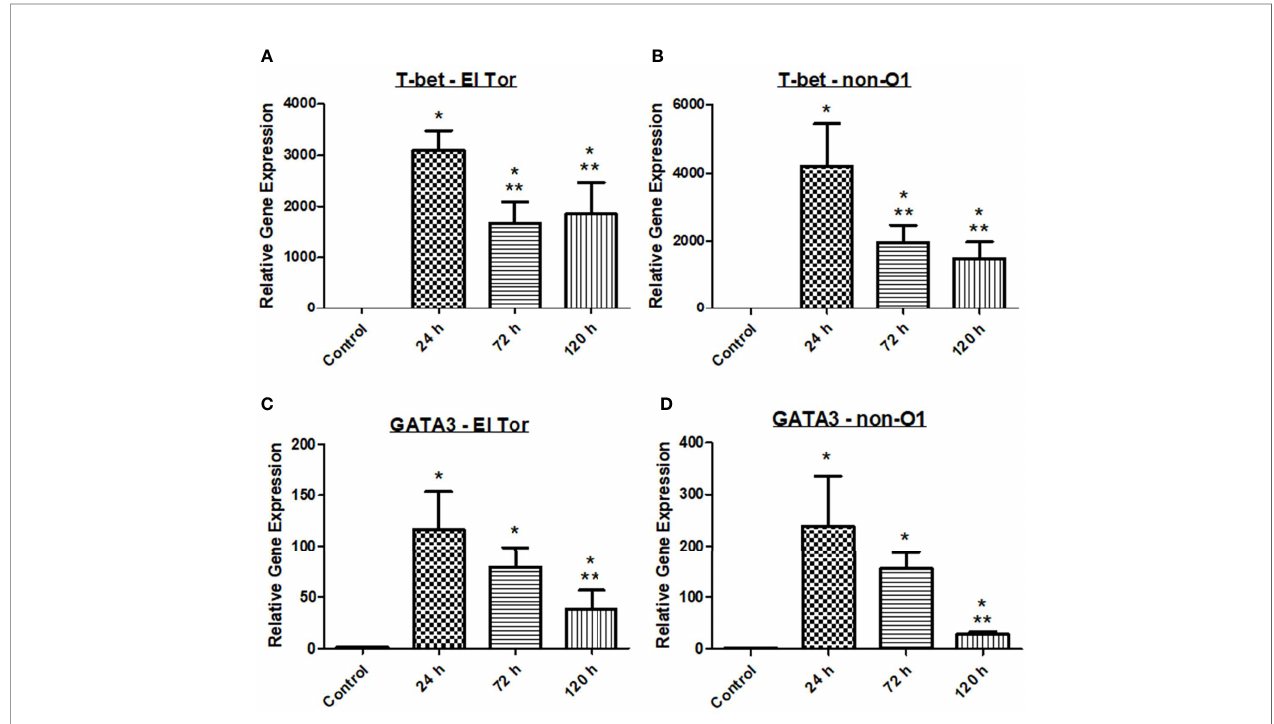
FIGURE 1 | Adaptive immune responses in zebra fi sh against V. cholerae infection. WT zebra fi sh (n=5) were infected with E7946 (El Tor) or 25493 (non-O1) strains of V. cholerae at 2.5 x 10 7 CFU/mL and then sacri fi ced at the indicated time points. (A) T-bet expression in fi sh infected with El Tor strain E7946. (B) T-bet expression in fi sh infected withnon-O1 strain 25493. (C) GATA3 expression in fi sh infected with El Tor strain E7946. (D) GATA3 expression in fi sh infected with non-O1 strain 25493. T-bet and GATA3 gene expression levels in zebra fi sh mRNA were determined through qRT-PCR. Gene expression was normalized against b -actin and expressed as fold change. Error bars indicate standard deviation. Data shown is from three experiments. *P < 0.05 as compared to control, **P < 0.05 as compared to 24 h